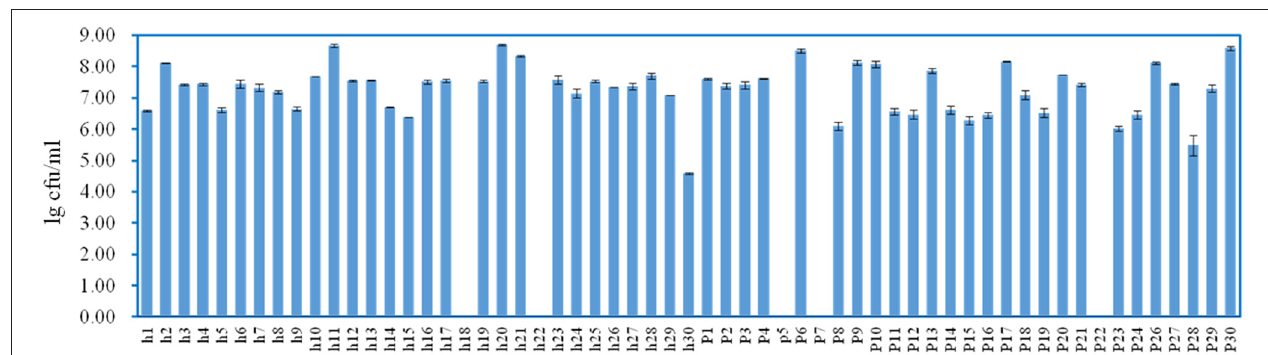
Frontiers in Microbiology |